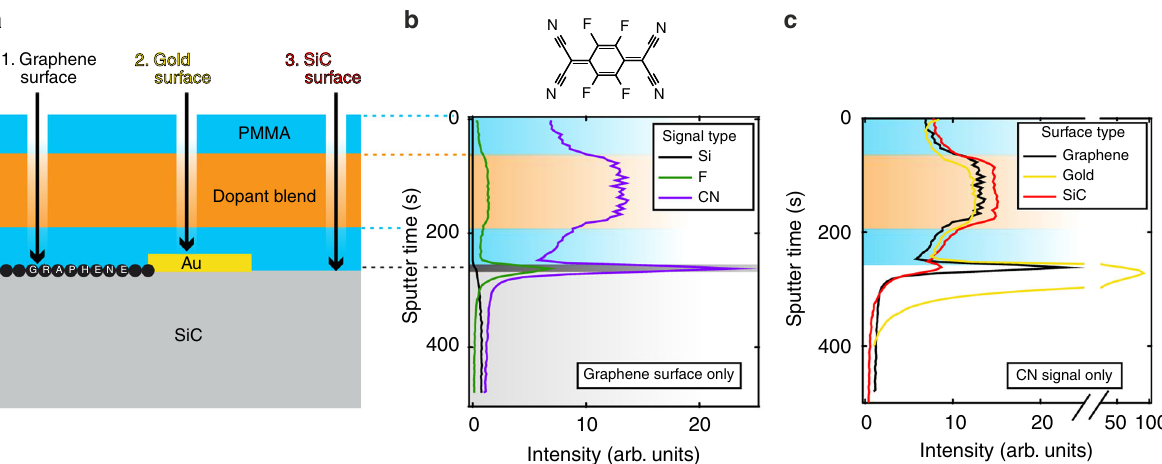
Fig. 2 Chemical pro fi ling of the polymer layers using ToF-SIMS to detect fi ngerprints of the F4TCNQ molecule (F and CN ions) as one probes deeper into the polymer stack. a Samples were prepared with PMMA spacer, dopant blend, and PMMA encapsulation layer. Three distinct spots on the substrate have been investigated: (1) graphene, (2) gold, and (3) SiC surfaces. b When analyzing the polymer layers on spot 1, above the graphene surface, the ion intensity for F and CN ions (top inset shows a schematic representation of a F4TCNQ molecule) vs. sputter time reveals signi fi cant accumulation of F4TCNQ at the graphene/PMMA interface, as well as the spatial distribution of F4TCNQ molecules through the spacer and encapsulation PMMA layers. The onset of the silicon signal (Si) is the marker, which indicates that the SiC substrate has been reached. The shaded regions denote the extent of each layer, from top PMMA layer down to SiC substrate. c Here we focus only on the CN signal measured at all three different spots. This analysis shows accumulation of F4TCNQ on the conductive surfaces of graphene and gold, but virtually no accumulation on